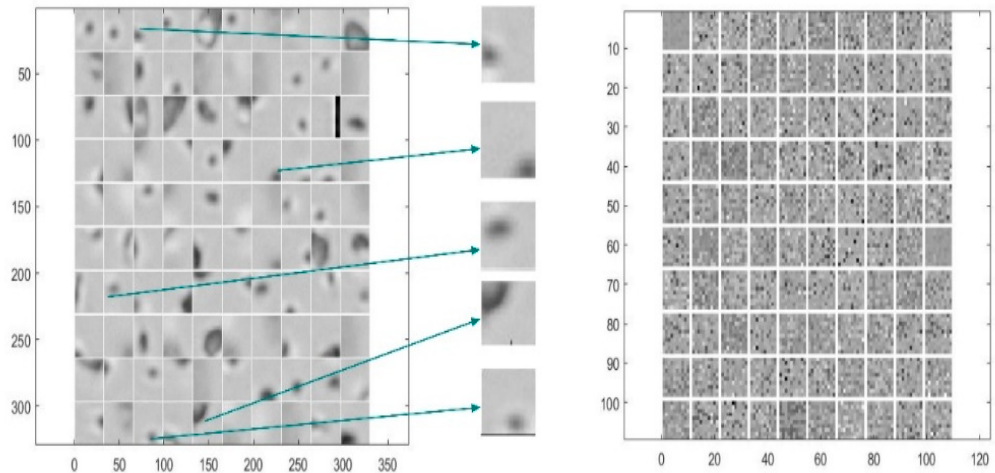
Figure 7. Left side : The visualization of 100 weights in the first layer of the deep belief network (DBN), restricted Boltzmann machines 1 (RBM1), and amplified images are some example of weights. Right side : The visualization of 100 weights in the second layer of DBN, RBM2. The segmentation results are shown in Figures 8–10 on different test axial images.